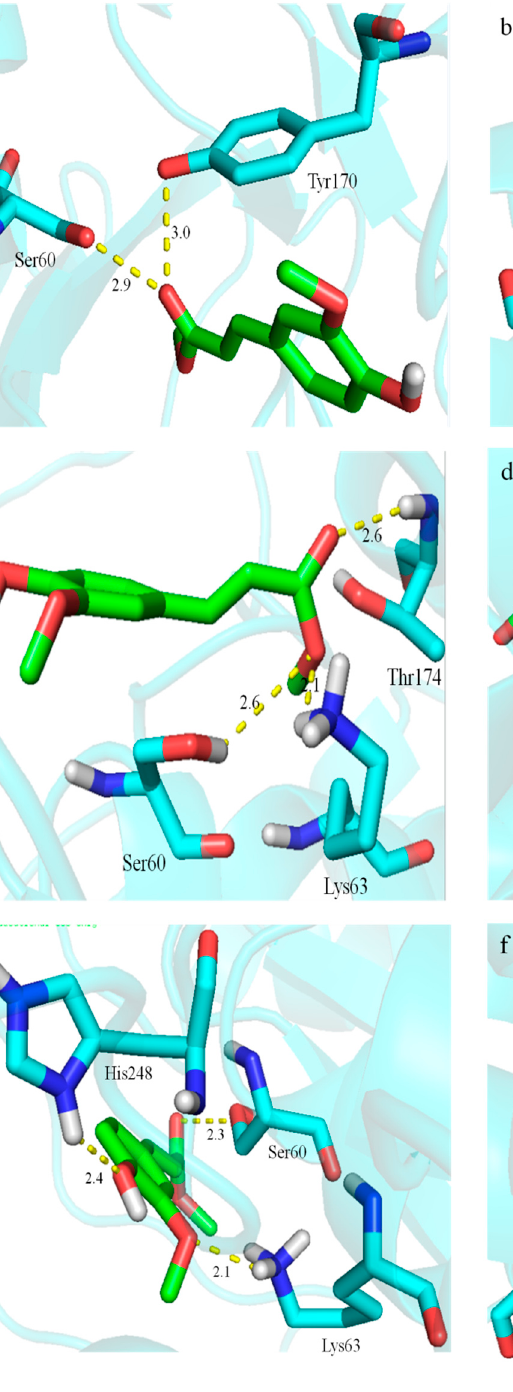
Figure 2. The hydrogen bond interaction between the active site of the enzyme and MFA. ( a ): DLFae4; ( b ): DLFae4-m1; ( c ): DLFae4-m2; ( d ): DLFae4-m3; ( e ): DLFae4-m4; ( f ): DLFae4-m5. The substrate MFA is represented by a green stick pattern, the amino acid residues that form hydrogen bonds with MFA are represented by a cyan stick pattern, and the hydrogen bonds are represented by a yellow dashed line.